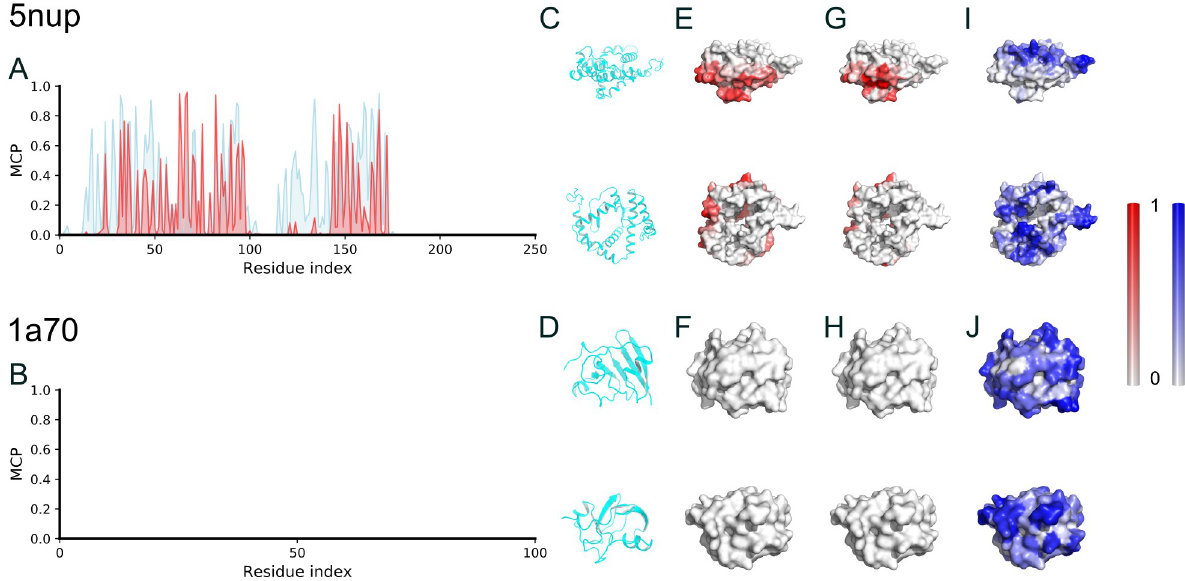
Fig 4. Membrane contact probability (MCP) of two representative non-transmembrane proteins. (A-B) Comparison between the MD observation (cyan) and the prediction (red) of the MCPs. (C-D), Side and top views of the two representative proteins. (E-F), The outer surface of the representative proteins, colored according to the MCP values obtained from MD simulations. (G-H), Similar to (E-F), but colored according to the predicted MCP values. (I-J), Similar to (E-F), but colored according to the predicted SA values by RaptorX. The PDB ID of the half-membrane- embedded protein was 5nup, which is an X-ray crystal structure of the Gram-negative bacterial α -helical outer membrane (OM) protein composed of 236 residues. The PDB ID of the soluble protein was 1a70, which is an X-ray crystal structure of ferredoxin I (Fd I) from Spinacia oleracea with 97